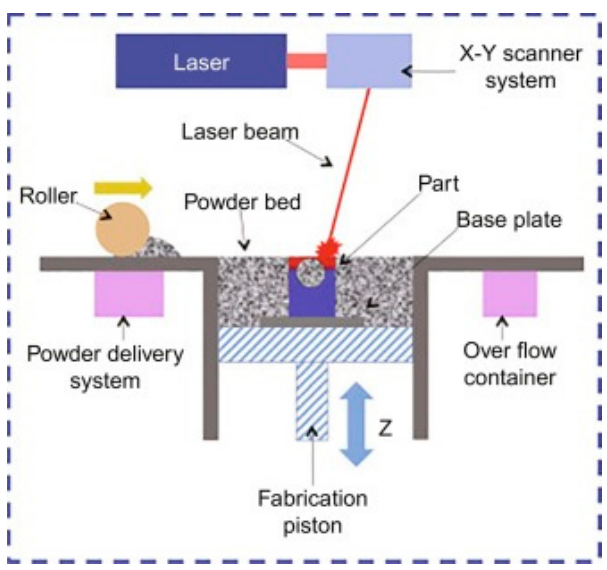
Figure 17. Selective laser melting (SLM) process (adapted with permission from reference [52]). SLM is a specific rapid prototype, 3D printing, and AM technology for the purpose of melting and fusing metallic powders using a high-power laser. A component is made by fusing and melting powder selectively inside and among layers. The SLM process is also often called direct selective laser sintering, laser curing, and direct laser sintering, and has been proven to generate up to a relative density of 99.9% in close proximity to net-shaped components (Figure 18). This makes it possible to create functioning components of almost full density and offers practical cost advantages. SLM can deal with a variety of metallic materials, including copper, aluminum, and tungsten, owing to recent advancements in fiber optics and high-power lasers. Similarly, research prospects in SLM of ceramic and composite materials have opened up as a result of this [53].